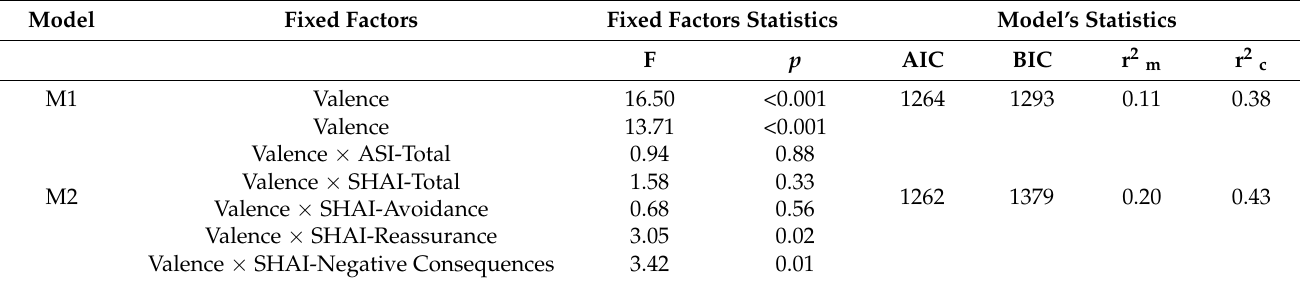
Table 4. M1 investigates the main effect of valence (positive vs. neutral vs. negative) on commission errors. M2 tests the interaction between valence and ASI and SHAI’s subscales scores. Model Fixed